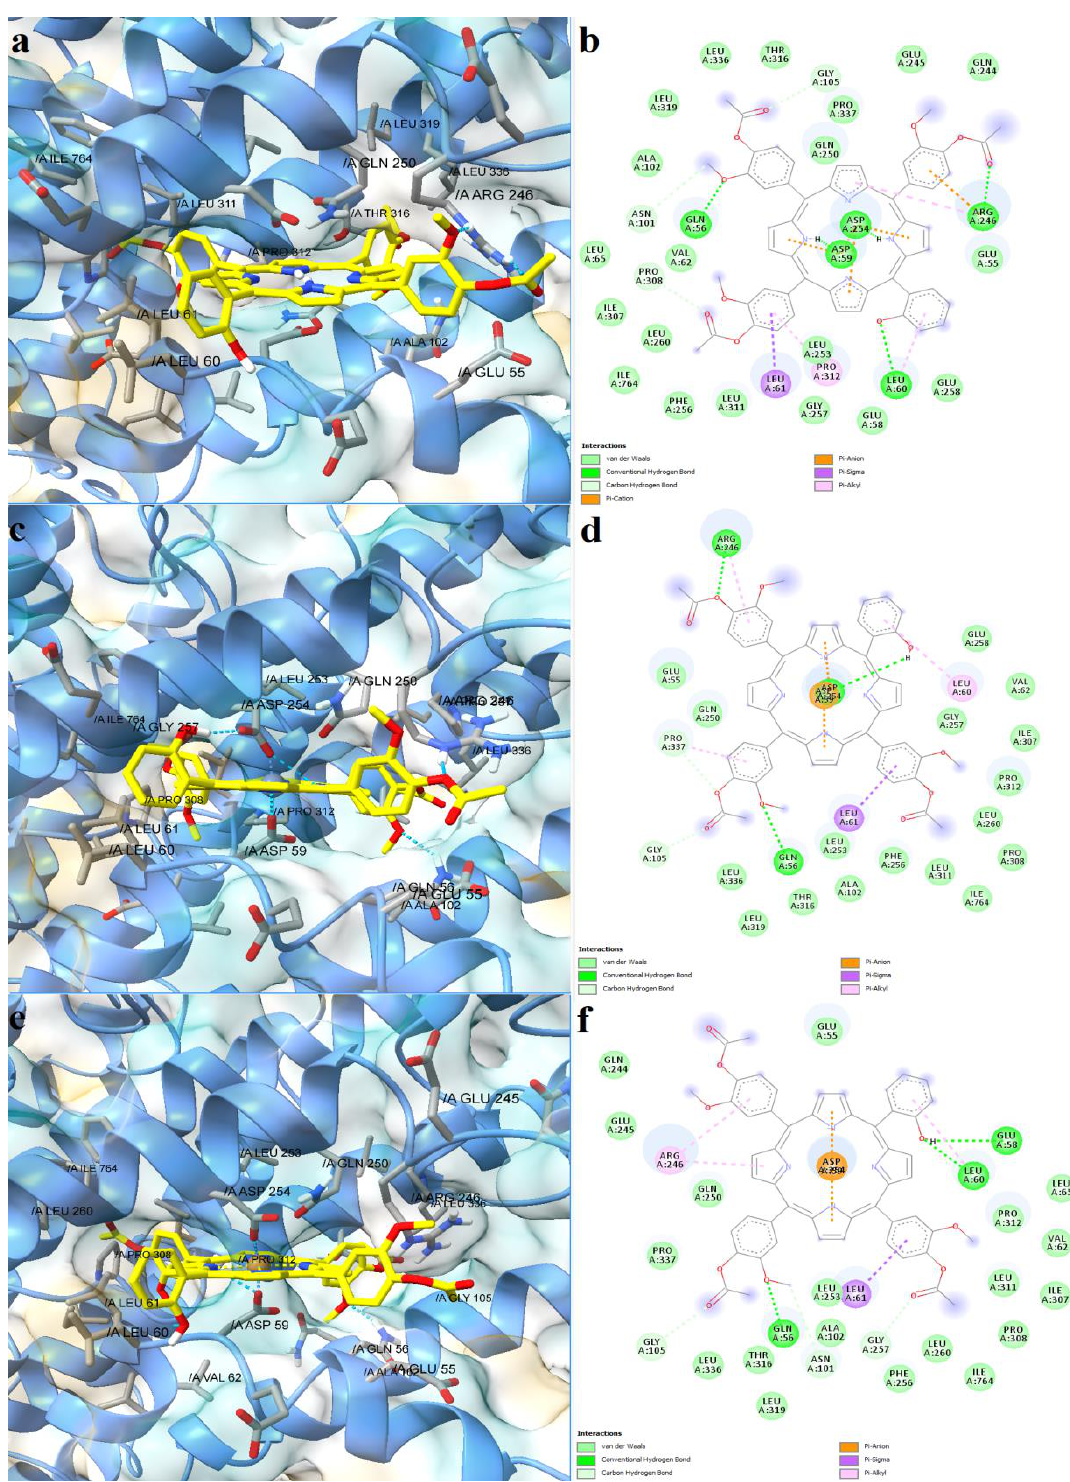
Figure 7. Predicted binding modes between porphyrin derivatives and SERCA2b. ( a ) — predicted conformation of TMAPOHo-SERCA2b complex; ( b ) — interaction diagram for TMAPOHo-SERCA2b complex; ( c ) — predicted conformation of Zn(II)TMAPOHo-SERCA2b complex; ( d ) — interaction diagram for Zn(II)TMAPOHo-SERCA2b complex; ( e ) — predicted conformation of Cu(II)TMAPOHo-SERCA2b complex; ( f )—interaction diagram for Cu(II)TMAPOHo-SERCA2b complex. Metal coordination bonds are represented as purple